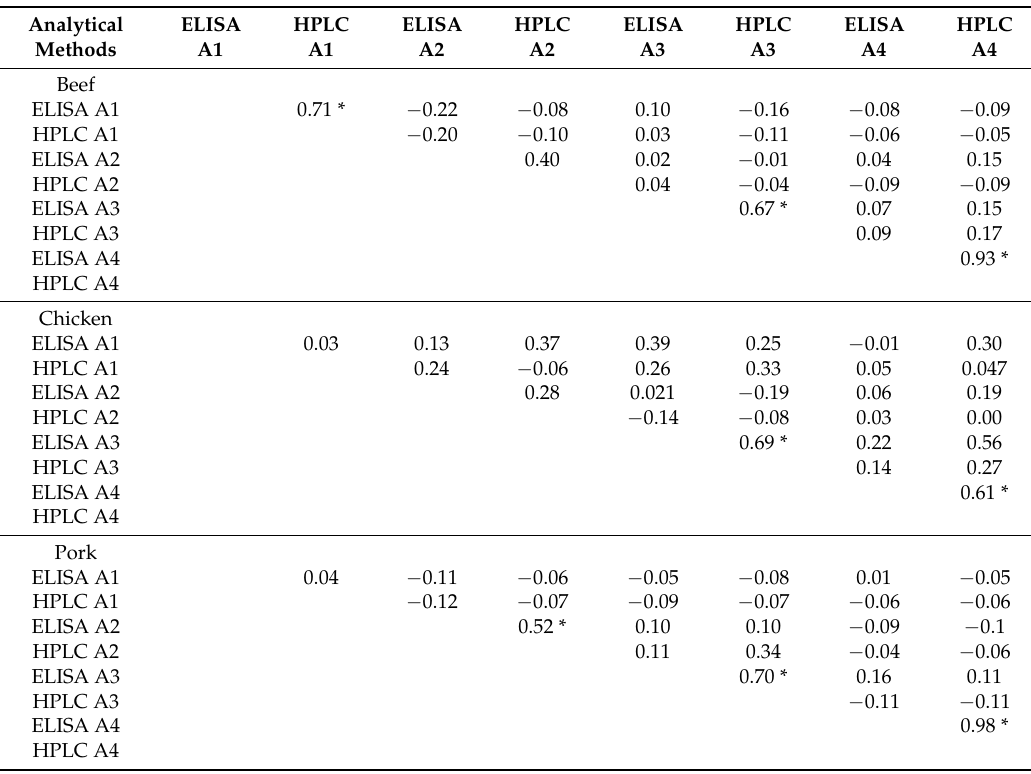
Table 7. Correlation between ELISA- and HPLC-detectable concentrations of ciprofloxacin, streptomycin, sulphanilamide, and tetracycline residues in beef, chicken and